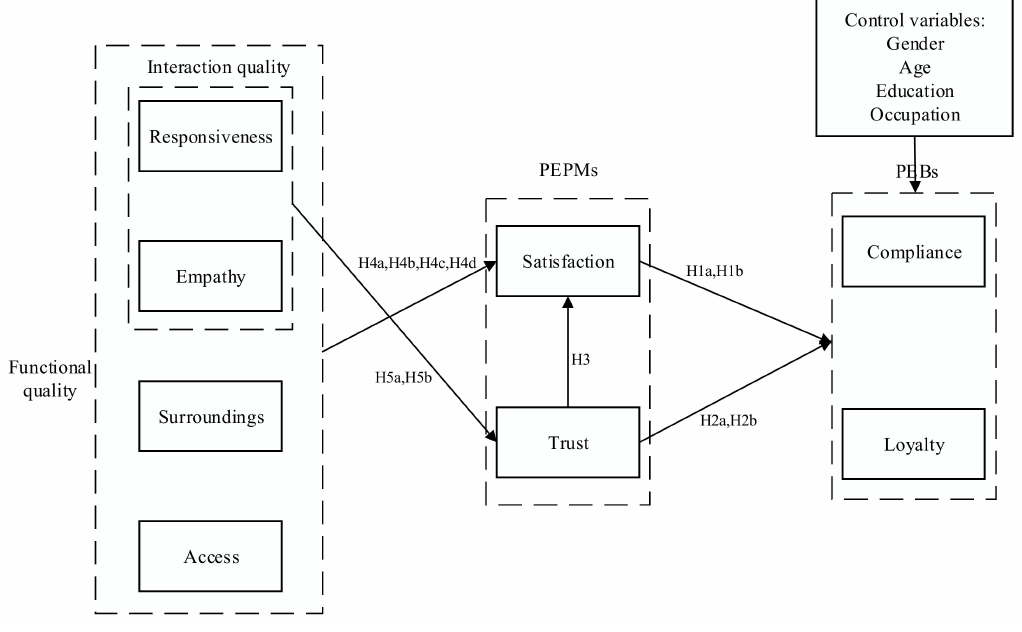
Figure 1. Research